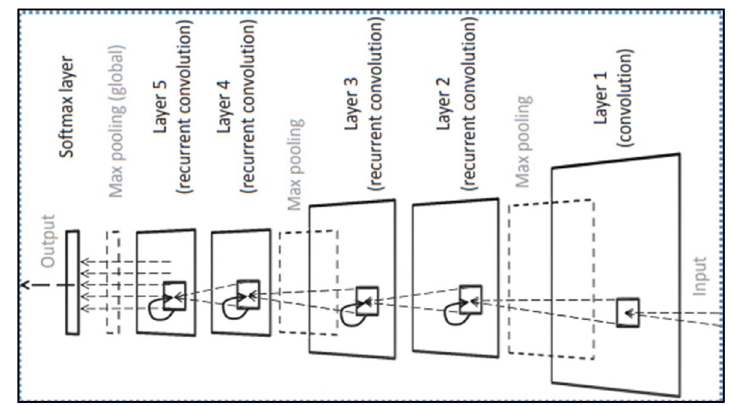
Fig. 22 RCNN with one convolutional layer, four RCLs, three max‑pooling layers, and one softmax layer